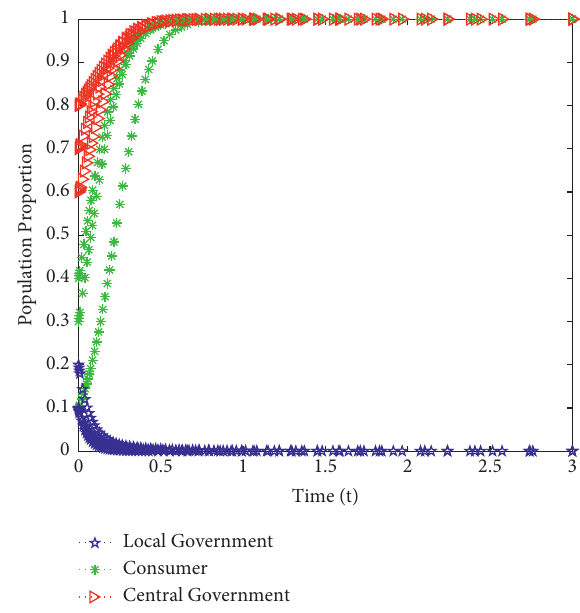
Figure 8: Evolution path of strategies chosen by three players with the stability point E 7